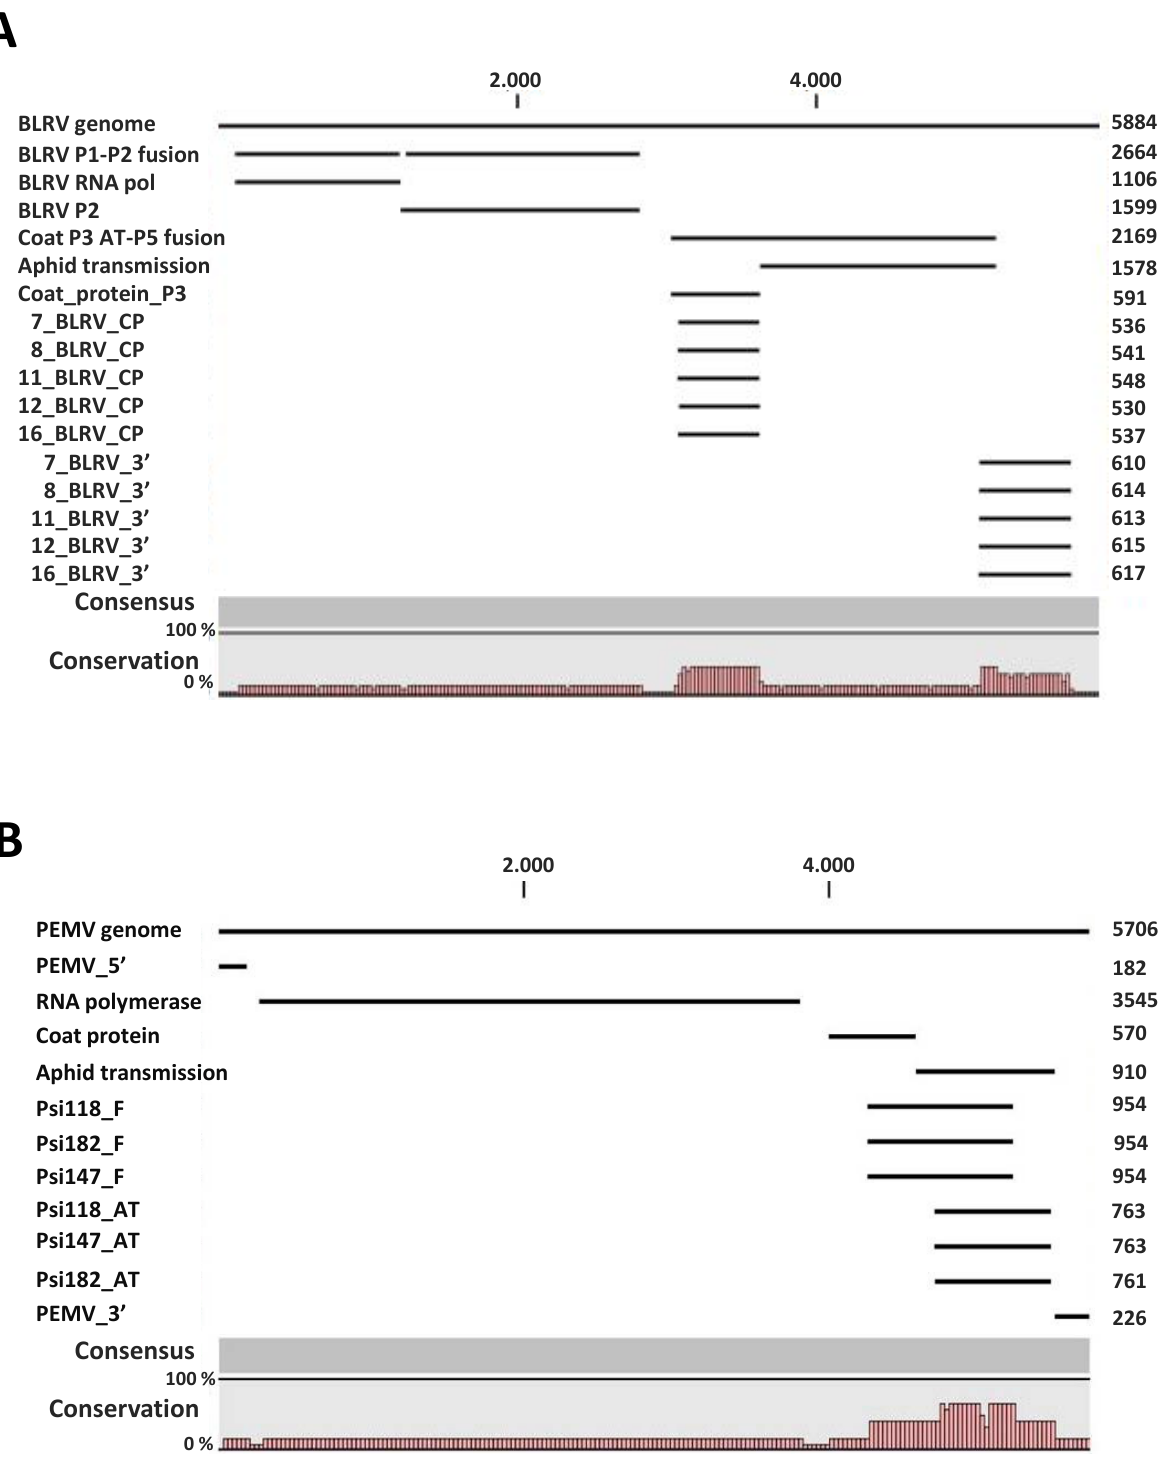
Figure 2. Graphical representation of the selected amplicons for Bean leafroll virus (BLRV) (Α) and Pea enation mosaic virus-1 (PEMV-1) (Β) against the genome of each Figure 2